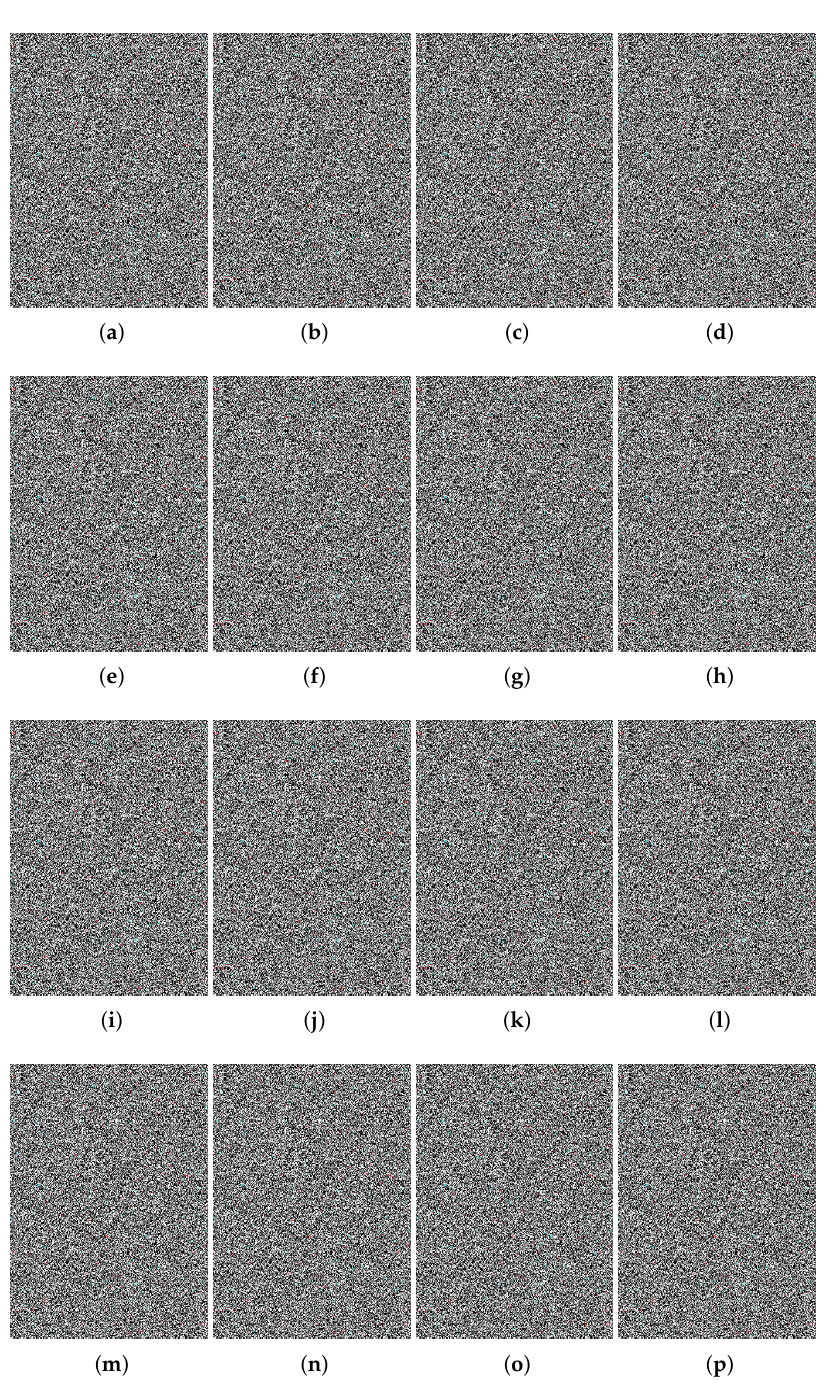
Figure 5. ( a – p ) Encrypted images corresponding to normal and pneumonia patients’ X-ray